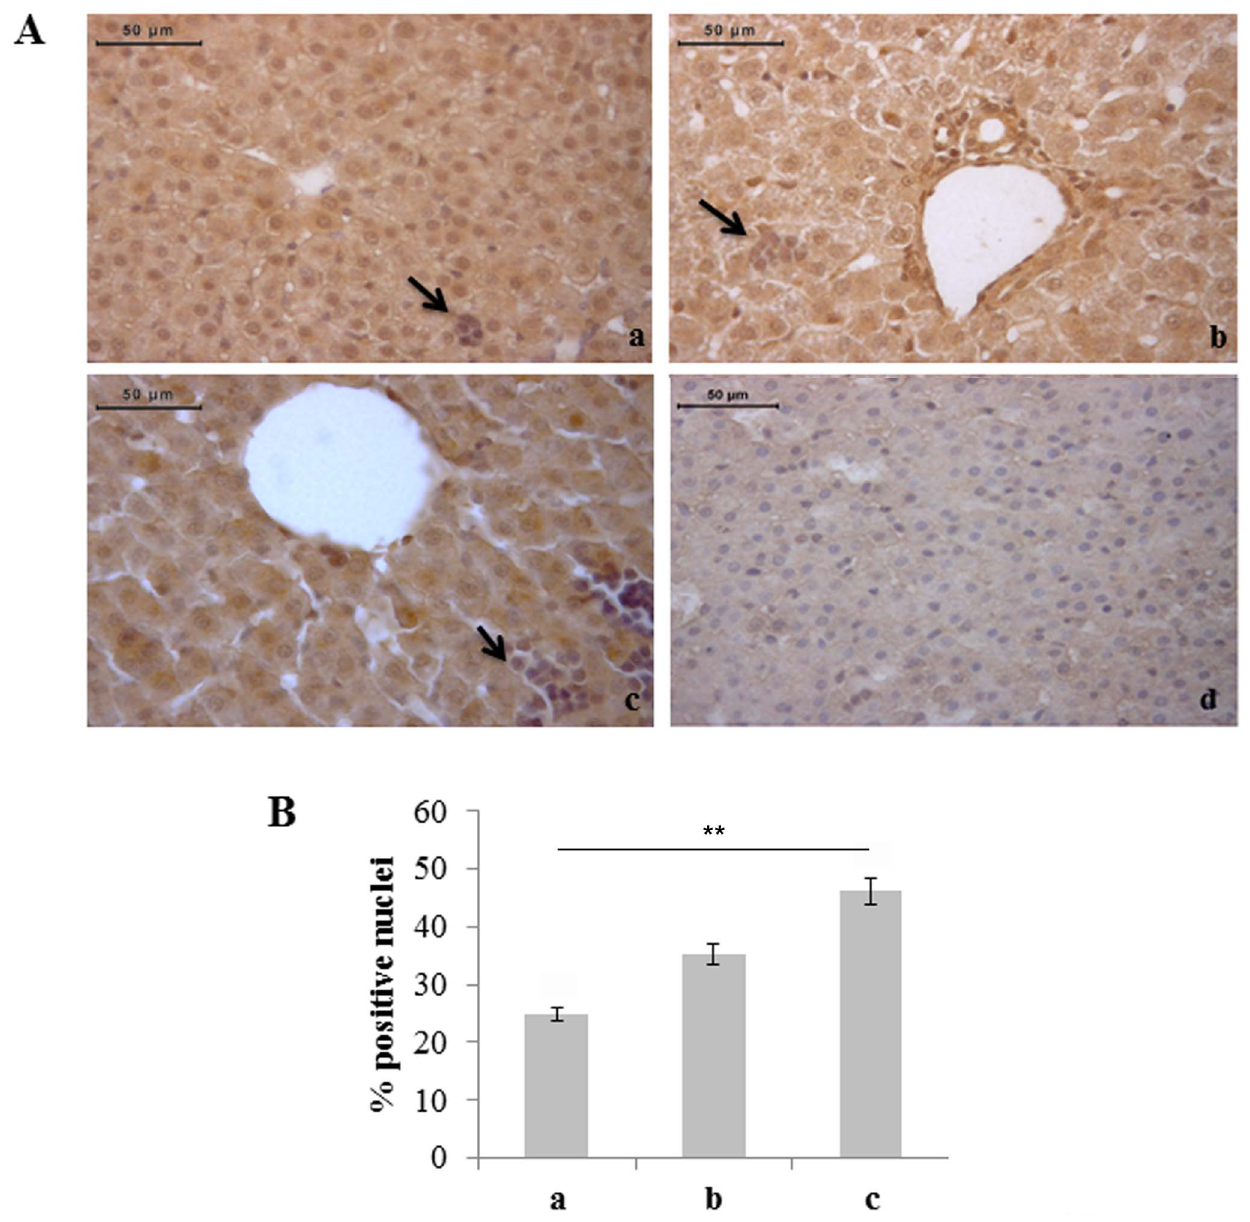
Figure 9. Severe hyperoxia increases eNOS expression in haemopoietic foci. A) Immunohistochemical detection of eNOS-positive haemopoietic cells (arrows) in neonatal rat livers exposed to moderate and severe hyperoxia. a) ambient air; b) 60% hyperoxia; c) 95% hyperoxia; d) negative control; scale bar: 50 m m, magnification 40x. B) Graphic representation of the percentages of eNOS-positive haemopoietic cells ( 6 SD); densitometric analysis determined by direct visual counting of ten fields for each of three slides per sample. **=p ,